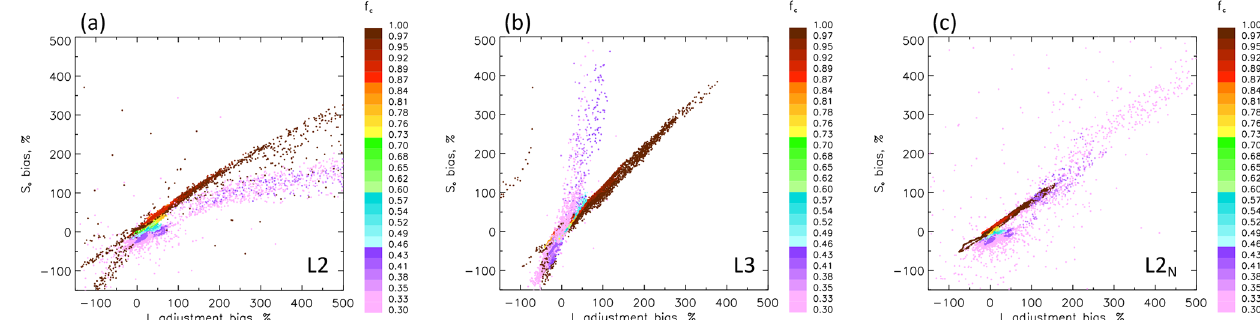
Figure 10. S o bias vs. the L adjustment bias ( d ln L /d ln N d in Eq. 1) for a limited set of model scenes (for clarity). Note a strong positive correlation between the two biases, as expected from Eq. (1). In (a) and (b) , the relative magnitude of these biases depends on f c , although with an opposite trend. In (a) and (c) , the L adjustment bias tends to be larger than the S o bias.